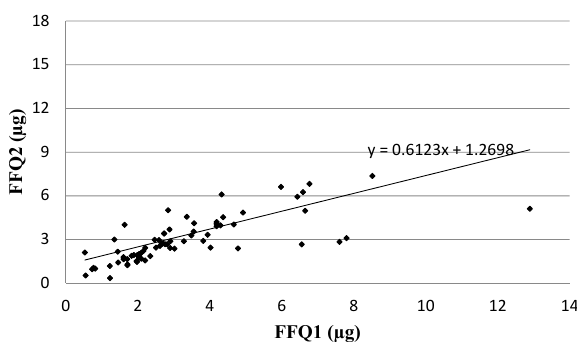
Figure 3. Analysis of correlation between VIDEO-FFQ1 and VIDEO-FFQ2 of Vitamin D daily intake (Spearman rank correlation coefficient; p < 0.01, R = 0.8235). FFQ1—VIDEO-FFQ filled out